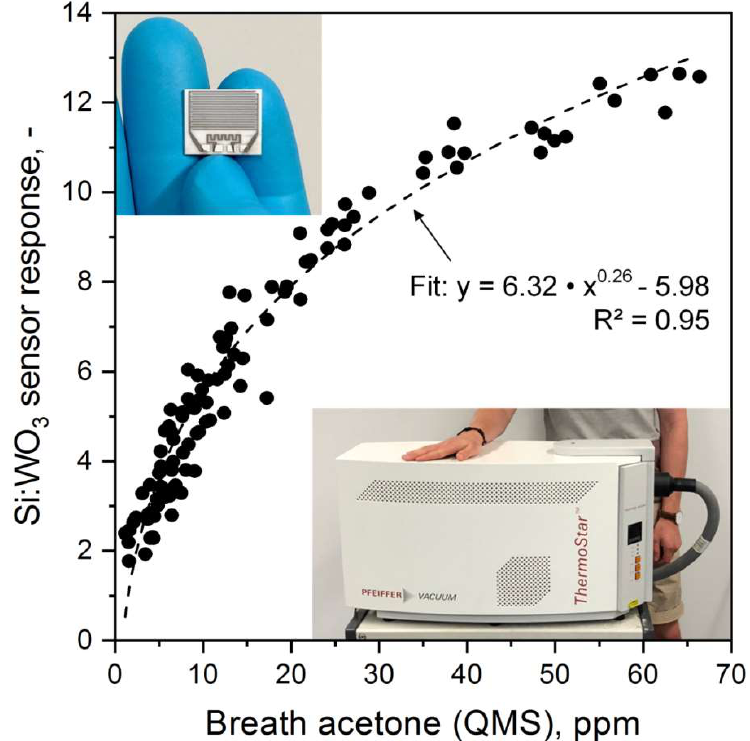
Figure 2. Scatter plot between the Si-doped WO 3 sensor responses and QMS-measured acetone concentrations of 105 breath samples (11 volunteers). Power law fit is indicated as dashed line together with the corresponding coefficient of determination (R 2 ). Inset images show the sensor chip (top left) and the QMS instrument (bottom right).